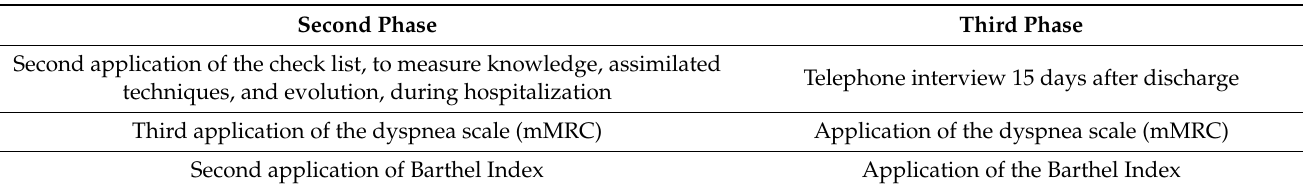
Table 2. Second phase and third phase (15 days after